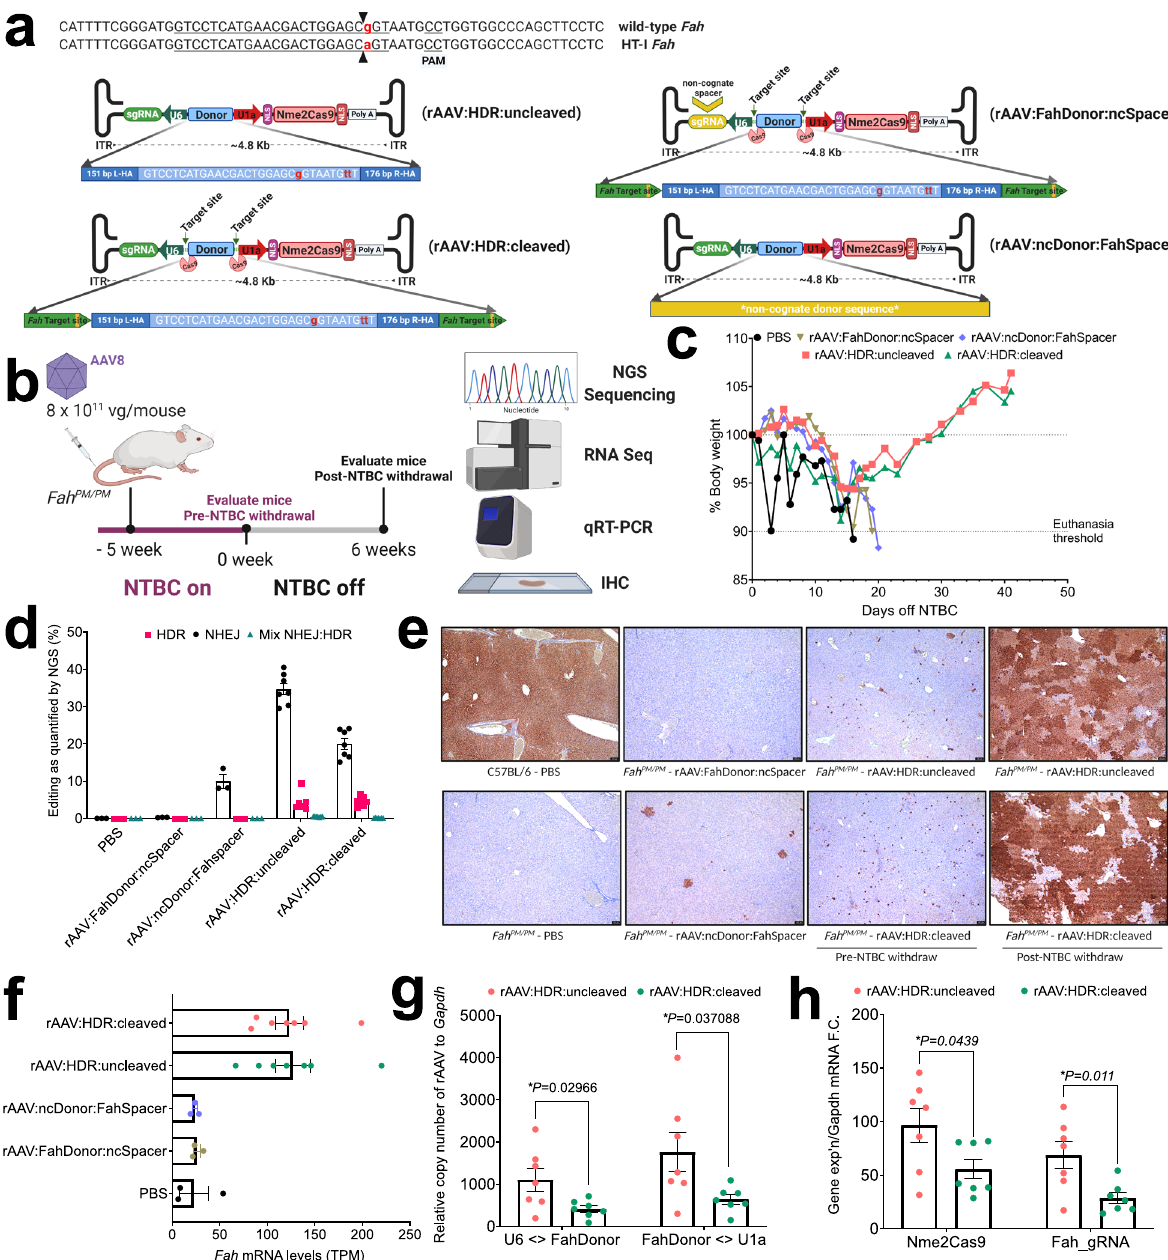
Fig. 4 rAAV:HDR vectors rescue liver disease phenotypes in a mouse model of HT-I. a Schematic of rAAV:HDR:uncleaved and -cleaved vectors (left) and control non-cognate donor or spacer vectors (right) to correct the Fah point mutation in Fah PM/PM mice (top). b In vivo experimental regimen to correct the Fah mutation by injection of AAV8 through the tail vein in adult Fah PM/PM mice. c Complete rescue of average body weight loss in Fah PM/PM mice in treated cohorts injected with rAAV:HDR:uncleaved (red) and -cleaved (green), as compared to control cohorts injected with PBS (black), rAAV:FahDonor:ncSpacer (brown) or rAAV:ncDonor:FahSpacer (blue). Data shown represent the average body weight of each cohort. d Bar graph showing the percentage distribution of NHEJ, HDR, and imprecise NHEJ:HDR mix at Fah in livers of mice 6 weeks after NTBC withdrawal, as measured by NGS sequencing of PCR amplicons from genomic DNA. e Representative images of immunostaining for FAH in liver tissues of negative control and treated cohorts, as indicated below each panel. Scale bar, 100 μ m. All mice in each cohort were examined once by this method (see Supplementary Fig. 3). f Levels of Fah mRNA from RNA-seq (transcripts per million) in the livers of Fah PM/PM mice. g rAAV copy numbers in HT-I mouse liver tissues. rAAV copies are signi fi cantly reduced in rAAV:HDR:cleaved cohorts after NTBC withdrawal using the [U6<>FahDonor] primer pair (left) and [FahDonor<>U1a] primer pair (right). h qRT-PCR analyses with total RNA showing signi fi cantly reduced Nme2Cas9 mRNA and sgRNA expression in the rAAV:HDR:cleaved cohort after NTBC withdrawal. Data were presented as mean values ± s.e.m. Sample sizes in panels c , d , f – h : ( n = 3 in PBS, rAAV:FahDonor:ncSpacer, rAAV:ncDonor:FahSpacer and pre-NTBC withdrawal rAAV:HDR:cleaved and -uncleaved cohorts; n = 7 in post-NTBC withdrawal rAAV:HDR:cleaved and -uncleaved cohorts). p values are calculated using Student ’ s t -test (two-sided).